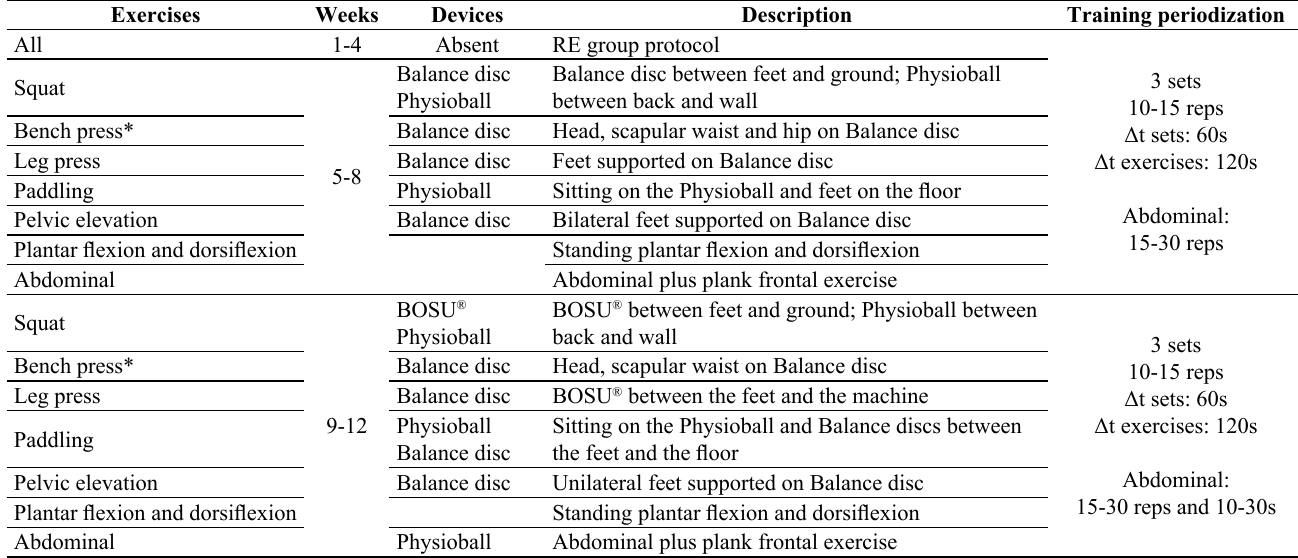
Table 1. REI training